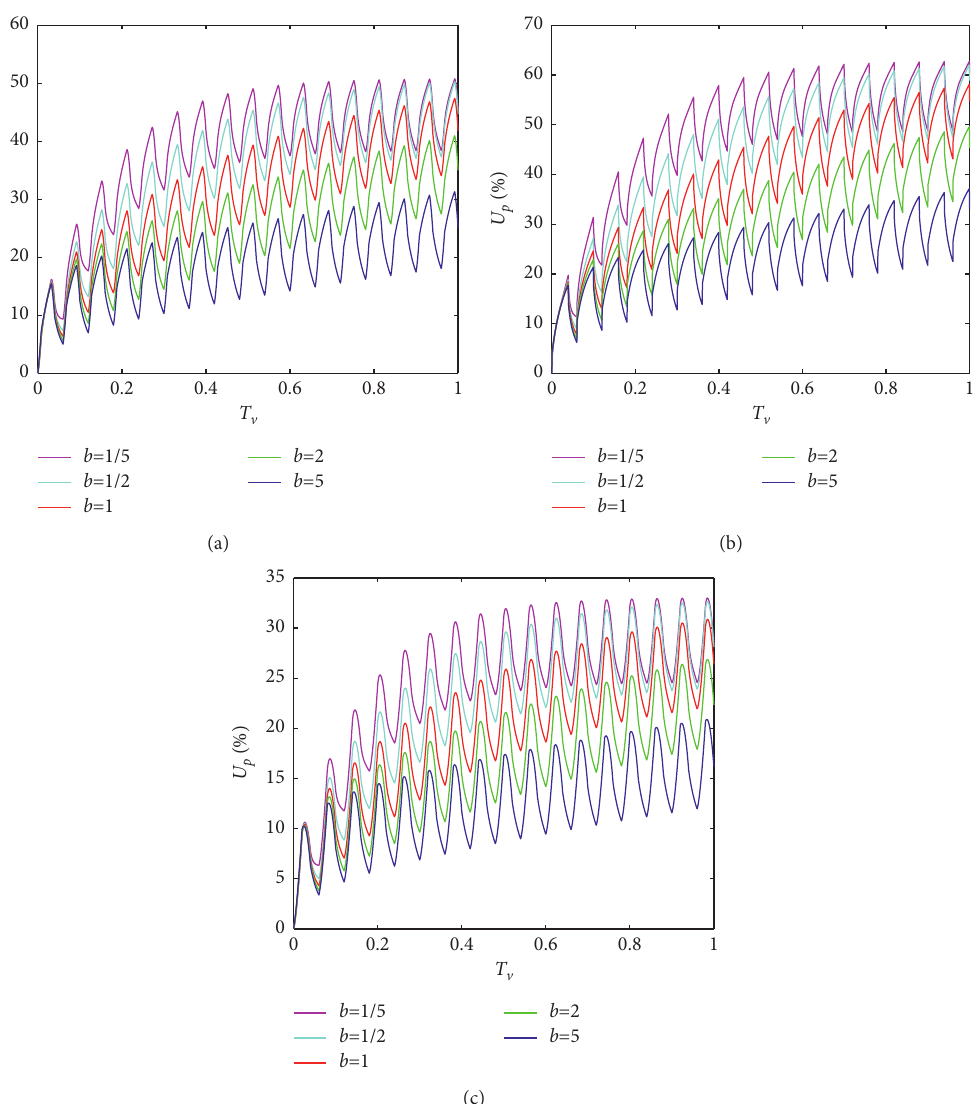
T v under different values of b p with time factor